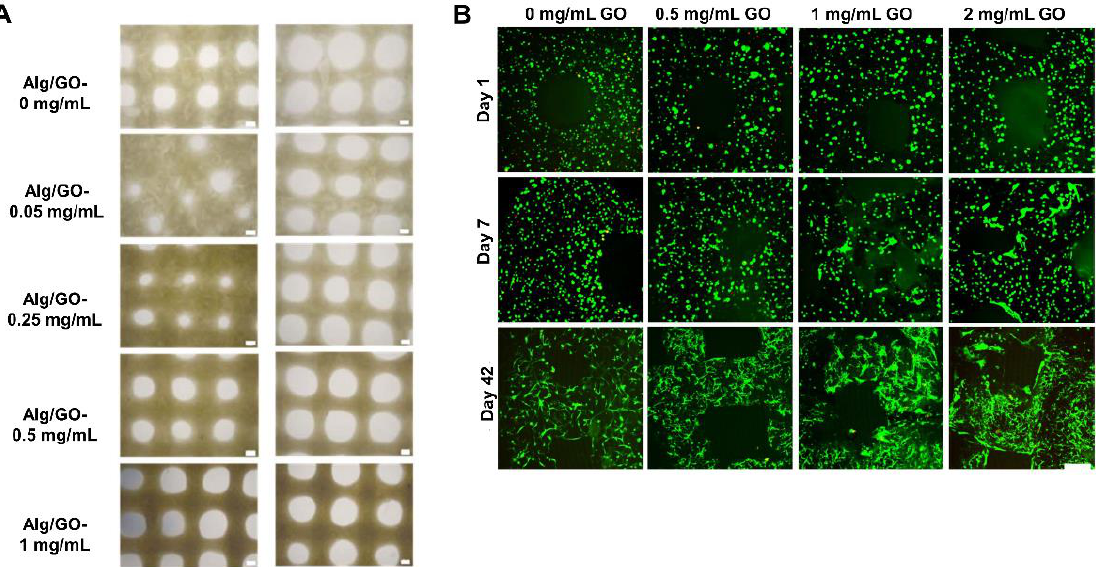
Figure 12. Graphene oxide scaffolds: ( A ) Optical images of the top view of the printed scaffolds, indicating better printability when GO increases from 0.05 mg/mL to 1 mg/mL. Scale bars = 300 μm. Adapted from [83]. ( B ) Cell viability in the 3D-bioprinted GO scaffolds at days 1, 7, and 42. Living cells are depicted in green, and dead cells are in red. Scale bar = 50 μm. Adapted from [84].